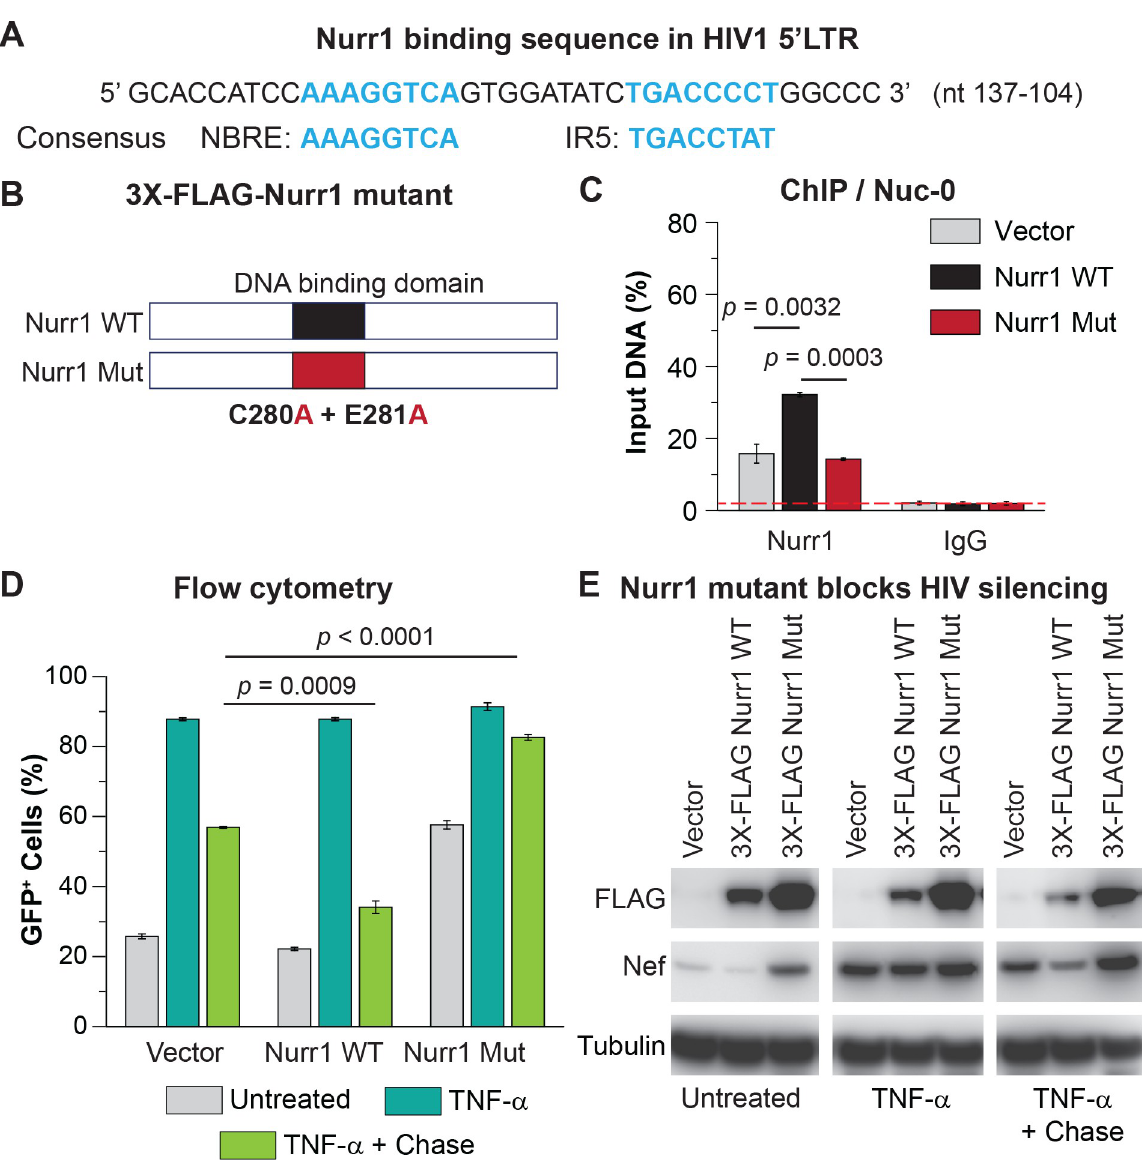
Fig 5. Nurr1 binds to conserved sites in the HIV LTR. A , Location of the putative Nurr1 binding site in the HIV LTR consists of a 8-nt NGFI-B-responsive element (NBRE) and an inverted 8-nt repeat (IR5), to which Nurr1 monomers, homodimers, and heterodimers bind [66]. B , Lentiviral construct expressing the DNA binding deficient 3X-FLAG-Nurr1 mutant (Nurr1 Mut) was generated from the original lentiviral construct expressing 3X-FLAG-Nurr1 wild type (Nurr1 WT) by converting both residues C280 and E281 to alanine (A) as reported previously [42]. C, ChIP assay measurement of the levels of Nurr1 protein at Nuc-0 in the HIV-1 LTR in HC69 cells expressing empty vector (grey bars), 3X-FLAG-Nurr1 WT (black bars), or 3X-FLAG-Nurr1 Mut (red bars). The mean levels of Nurr1 in 5’LTR, presented as the percentage (%) of ChIP product over input DNA of each sample, was calculated from triplicates qPCR of a single ChIP experiment using primers for the Nuc-0 region. D , Impact of overexpression of Nurr1 carrying DNA-binding defective mutations on GFP expression. HC69 cells expressing empty vector, 3X-FLAG-Nurr1 WT, or 3X-FLAG-Nurr1 Mut were induced with a high dose (400 pg/ml) TNF- α for 24 hr and then chased in the absence of TNF- α for 48 hr and the fraction of GFP+ cells was measured by flow cytometry. The p -values of pair-sample, Student’s t -tests for differences in the numbers of GFP+ cells between the control cells (Vector) and cells expressing wild-type Nurr1 (Nurr1 WT) or between the control cells (Vector) and cells expressing mutant Nurr1 (Nurr1 Mut) at the end of chase were calculated from three technical repeats. E , Impact of overexpression of Nurr1 carrying DNA-binding defective mutations on HIV Nef expression. Western blots were performed on HC69 cells expressing empty vector, 3X-FLAG-Nurr1 WT, or 3X-FLAG-Nurr1 Mut using antibodies directed against FLAG, Nef or β -Tubulin, which served as a loading